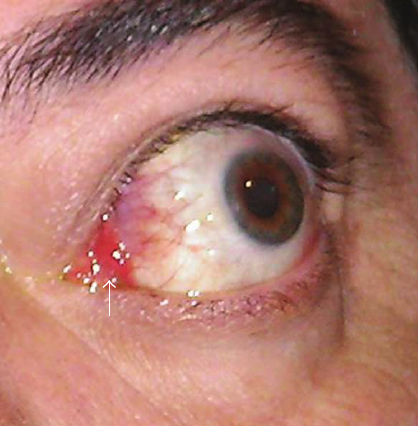
Figure 3: Inflammation of the plica (arrow) with diffuse conjuncti- val